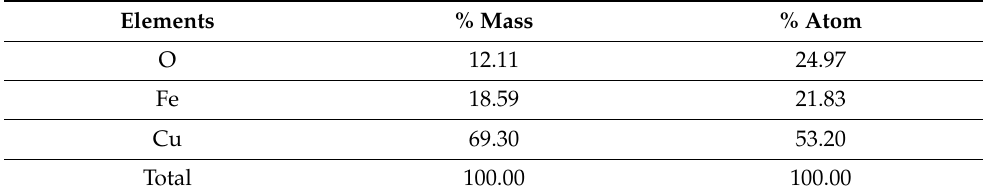
Table 3. Results of analyzing Fe-Cu sample elements.